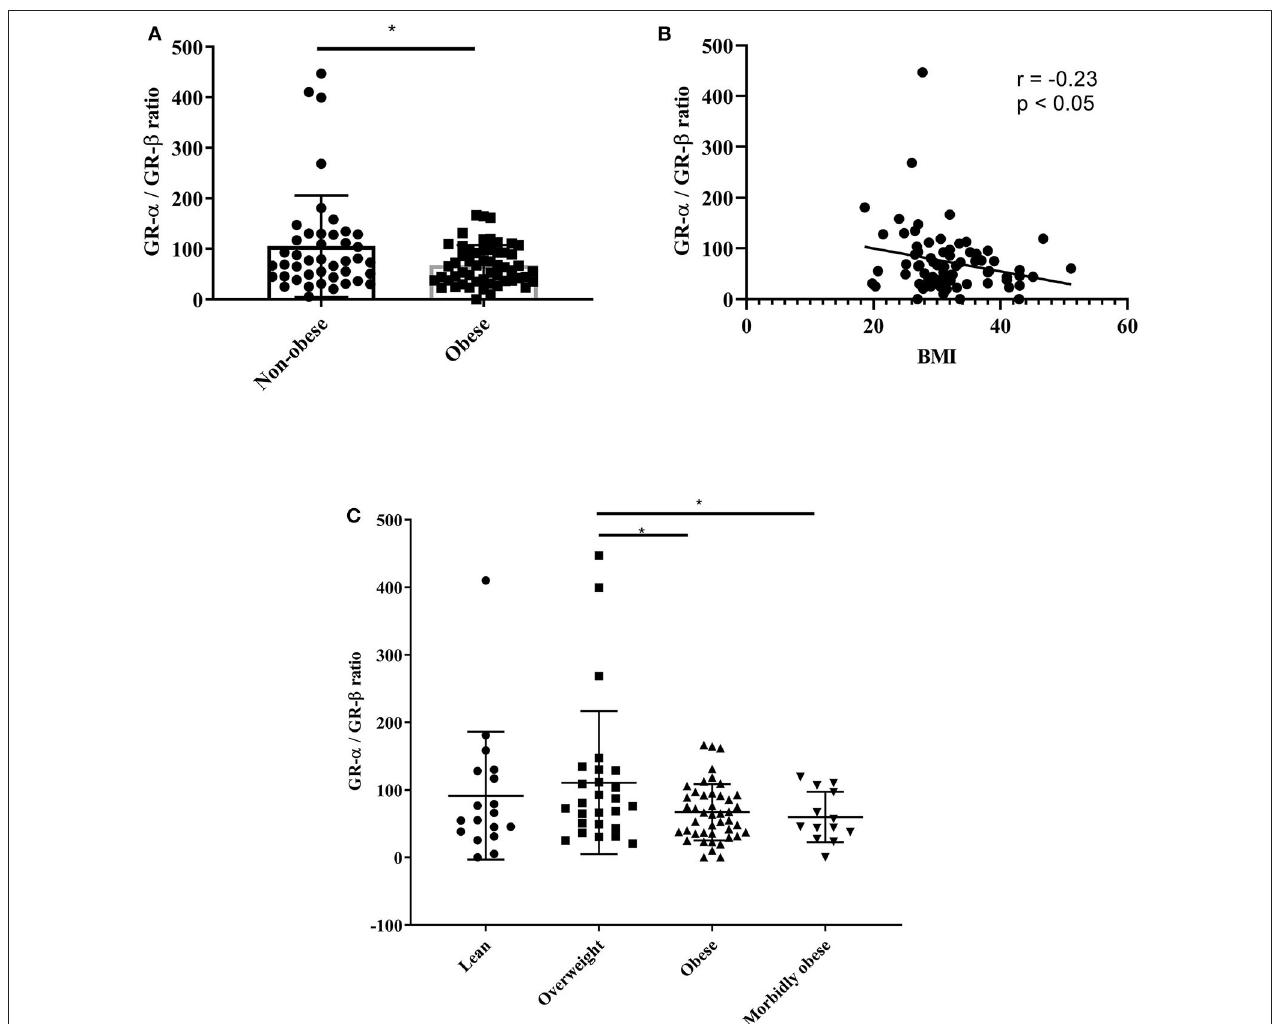
FIGURE 6 | GR- α /GR- β ratio is decreased in serum of obese asthmatic subjects. Serum was obtained from lean (BMI < 25 kg/m 2 ), overweight (BMI < 30 kg/m 2 ), obese (BMI < 35 kg/m 2 ), and morbidly obese (BMI > 35 kg/m 2 ) asthmatic subjects. (A,C) ELISA was used to assess protein levels of GR- α and GR- β . (B) Pearson correlation between BMI and GR- α /GR- β ratio. n = 43 non-obese subjects ( n = 18 lean, n = 26 overweight), n = 57 obese subjects ( n = 44 obese, n = 13 morbidly obese), Mean ± SE; * P <